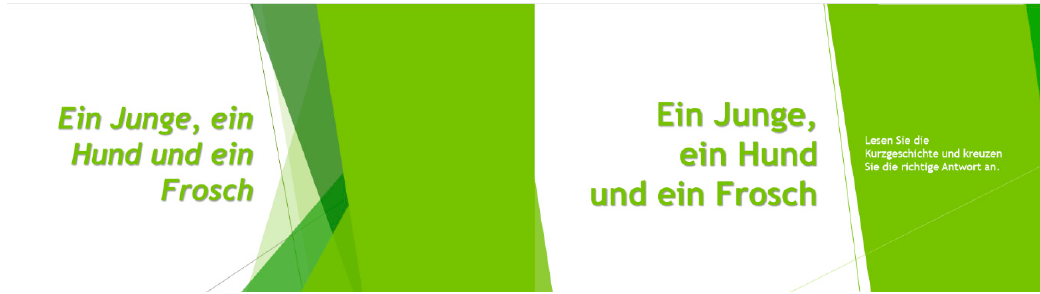
Figure A13. Pretest: Binary-choice recognition task.